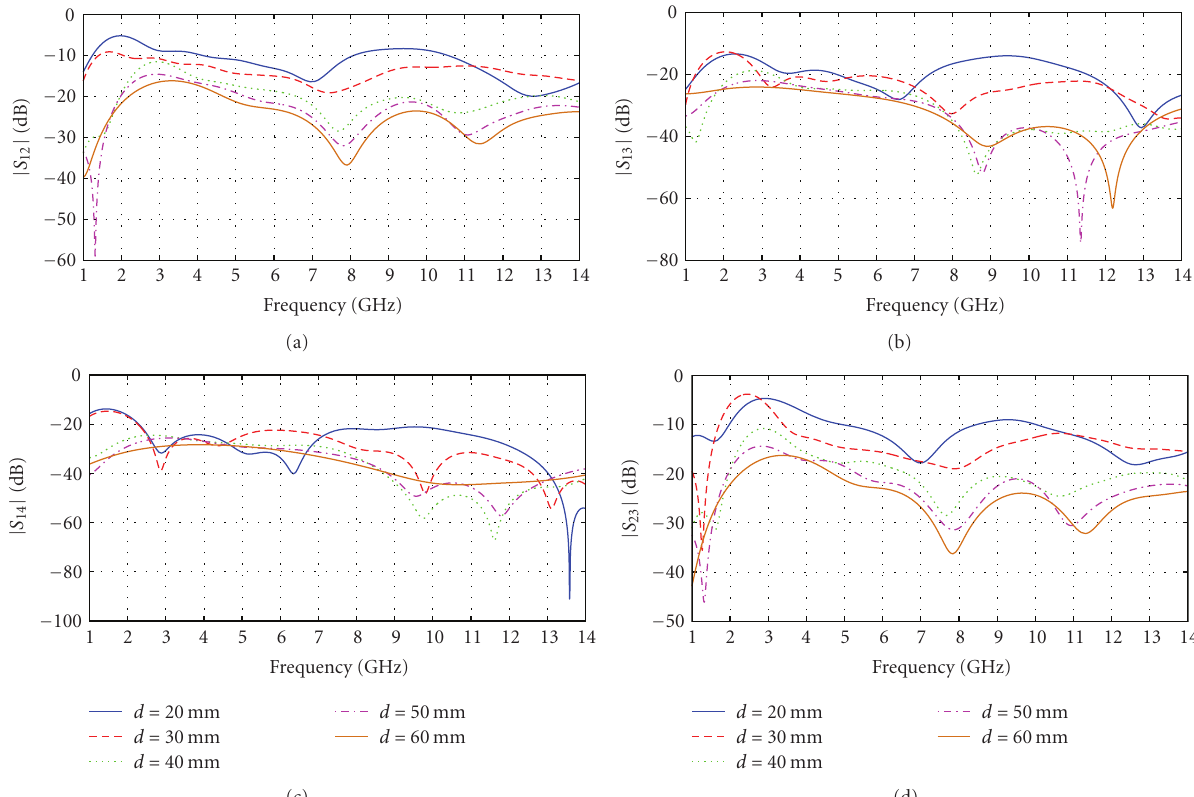
Figure 15: Simulated (a) | S 12 | , (b) | S 13 | , (c) | S 14 | , and (d) | S 23 | results of four-element UWB array.